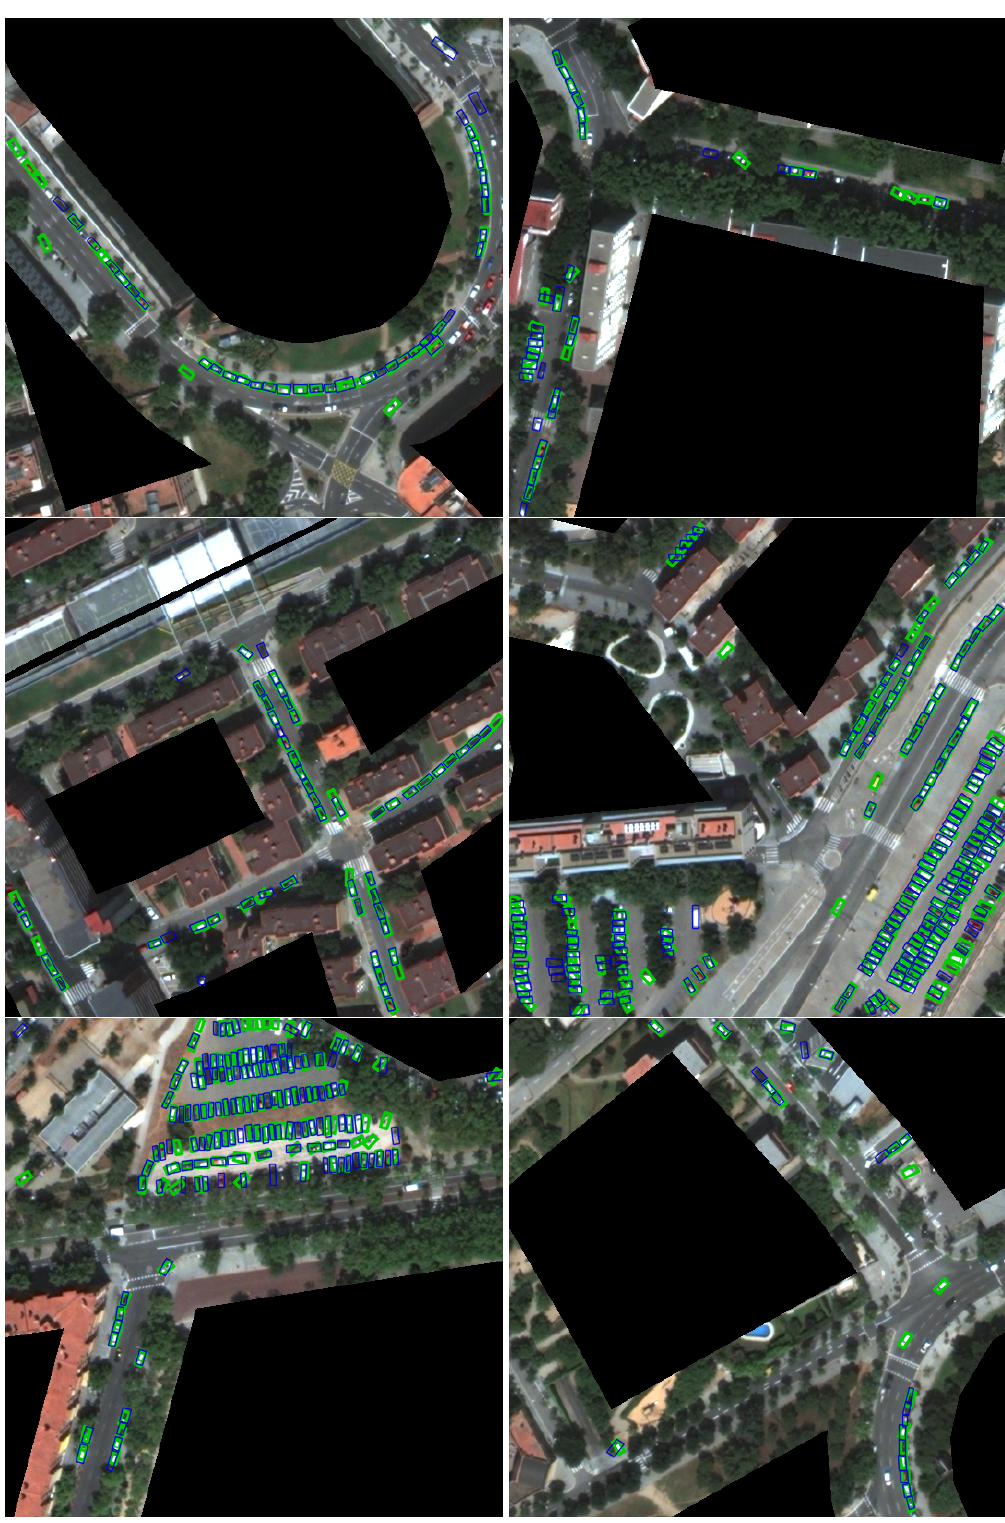
Figure 7. Examples of parking car detections on the Barcelona test set. Blue boxes depict ground truth, whereas green boxes depict the detections predicted with our early fusion methodology w/o